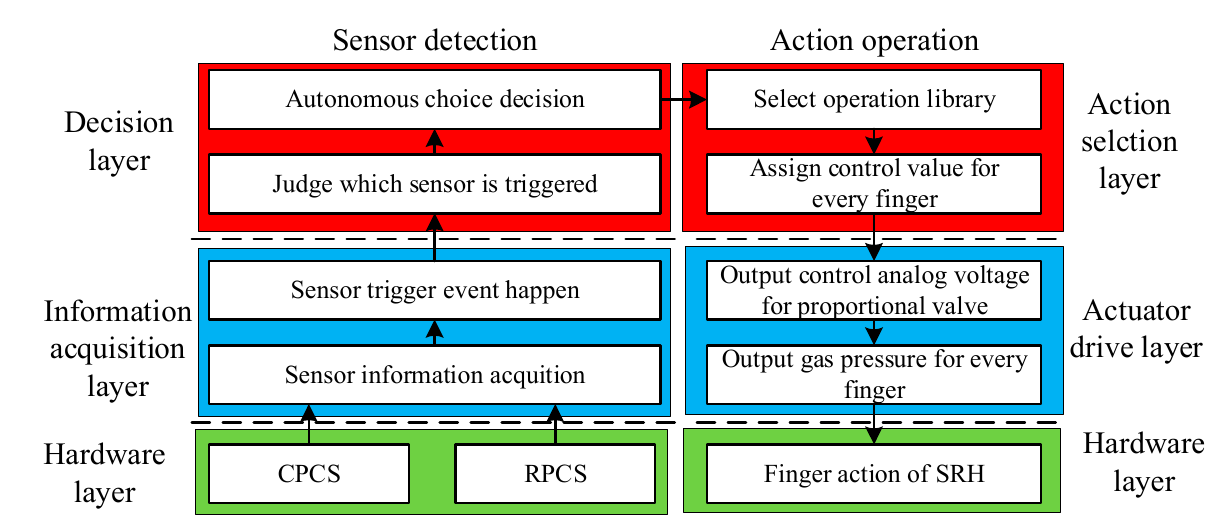
Figure 4. The framework of TDO.